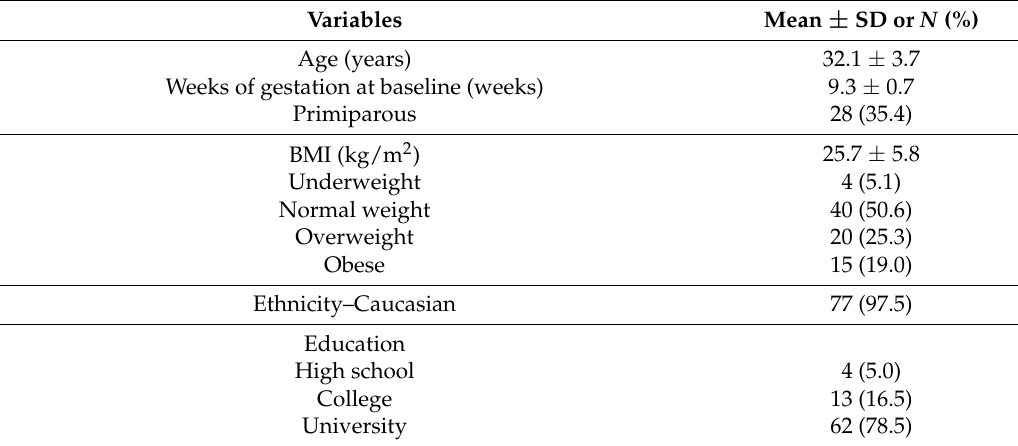
Table 1. Participants’ characteristics ( n =